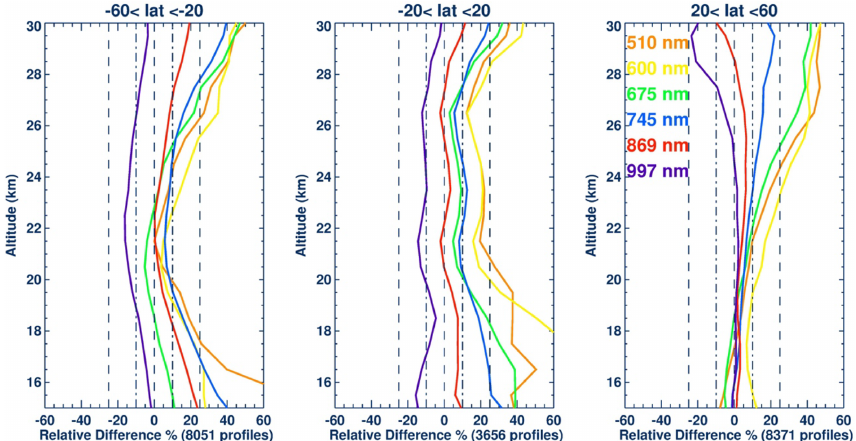
Figure 6. Summary plot of the average percent difference between OMPS LP and SAGE III profiles in percent at three different latitudinal zones for six wavelengths: 510 (orange), 600 (yellow), 675 (green), 745 (blue), 869 (red) and 997nm